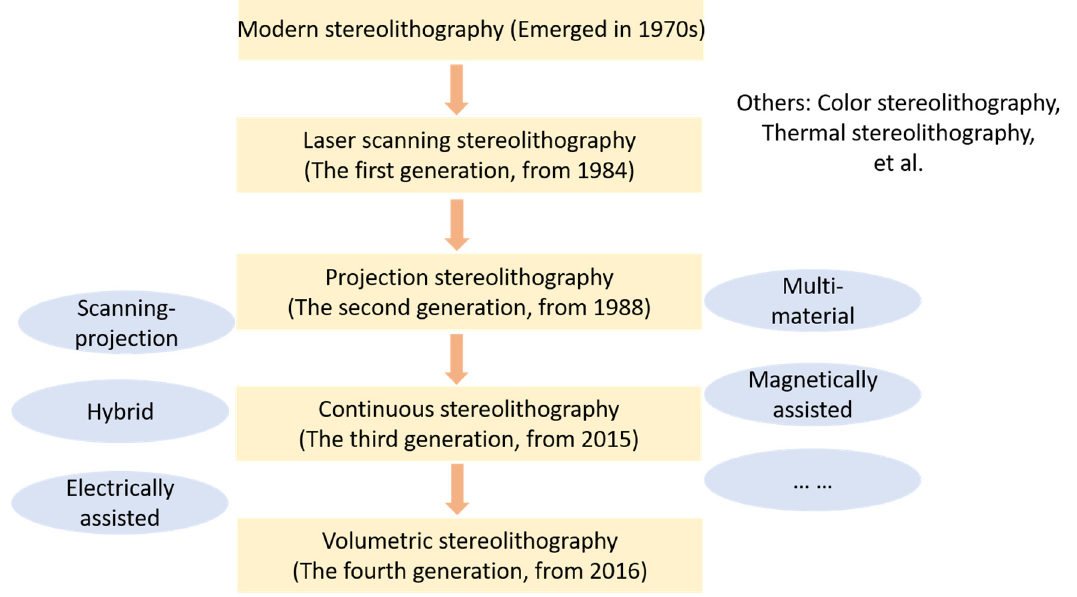
Figure 2. The overview of stereolithography [18,19,22–29]. As supplements, other kinds of processes and systems have also been provided (see Section 4), such as the scanning–projection process, hybrid stereolithography process, and multi-material